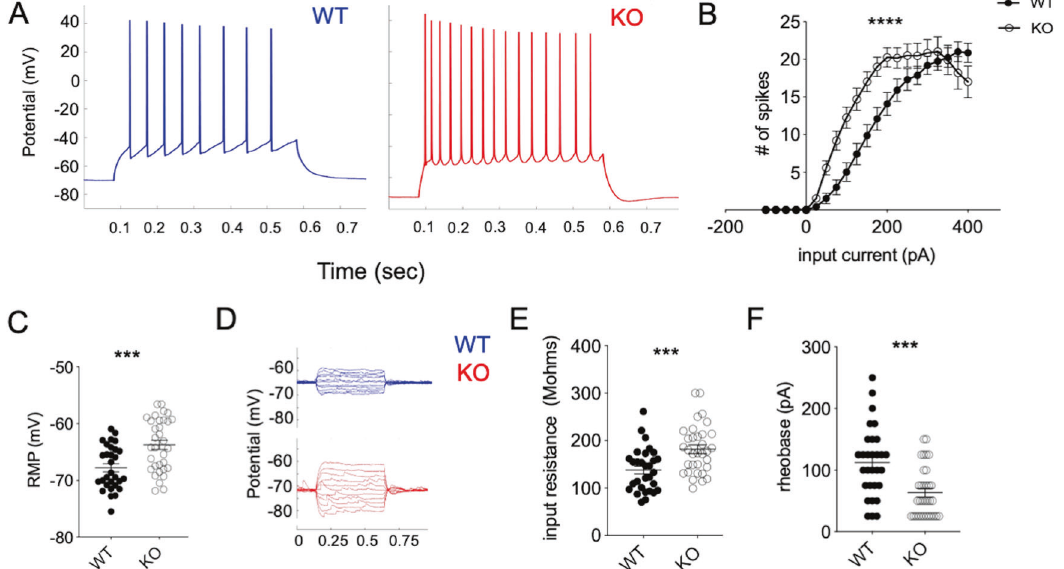
Fig. 3 Tcf4 deletion in adult excitatory neuron results in hyperexcitability. A Representative traces for action potential spikes from CA1 neurons of WT and KO brains. B F – I curve for fi ring (two-way ANOVA, **** p < 0.0001, error bar represents SEM). C – F Cell-intrinsic properties of CA1 neurons. C Resting membrane potential (WT: SEM + / − 0.7, KO: SEM + / − 0.8). D Input resistance traces (WT: SEM + / − 8.3, KO: SEM + / − 8.9) and E quanti fi cation. F Rheobase (WT: SEM + / − 10.36, KO: SEM + / − 7). Recording from 27 neurons from WT and 33 neurons from KO brains 2 – 3 weeks post deletion, representing ~5 – 6 mice per genotype. Mann – Whitney test: *** p < 0.0005, **** p <